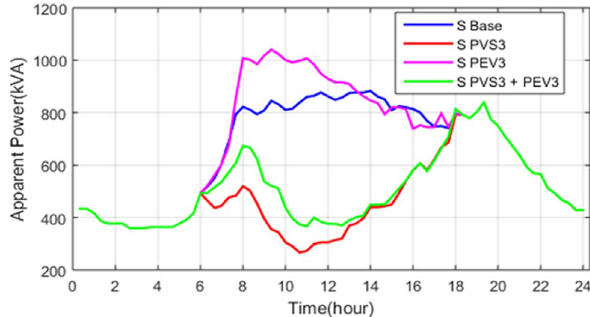
Figure 8. Analysis of day-to-day outlines of pro fi table load at the transmitter 2 thru summertime.